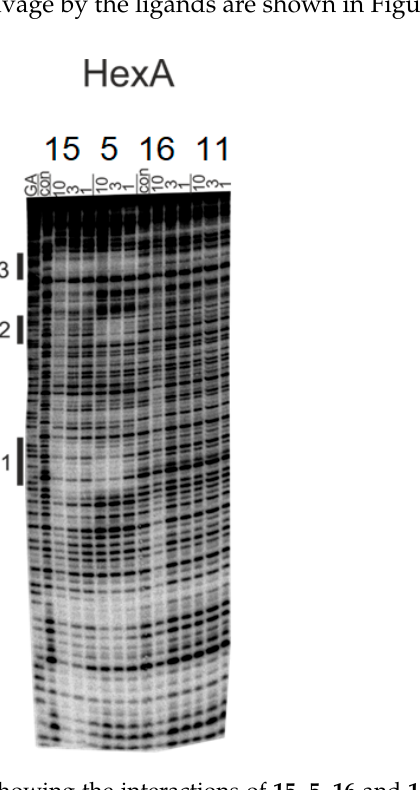
Figure 2. DNase I footprinting gels showing the interactions of 15 , 5 , 16 and 11 at 10, 3 and 1 µM concentrations with the HexA fragment. The samples were incubated with the ligand at room temperature for 24 hours before digesting with DNase I. Ligand concentrations are shown at the top of each gel lane. The tracks labelled “GA” correspond to a marker specific for purines, whereas “Con” indicates DNase I cleavage in the absence of the added ligands. Filled bars (with numbers) indicate the location of the footprints. In HexA, only PBDs 5 and 15 produced clear footprints at 5 ′ -TTAAGT/ACTAGT (site 1), 5 ′ - ACCGGT/ACCTAG (site 2) and 5 ′ -CTAGAA/TTCCGG (site 3). DC-81 ( 5 ) bound to site 1 at 3 µM and to sites 2 and 3 at the lowest concentration (1 µM), whereas benzylated PBD 15 only gave weak protection from DNase I cleavage at sites 1 and 3 at 10 and 3 µM. Examination of the footprints with the DNA fragments revealed the presence of the preferred PBD binding motif, Pu–G–Pu, for ligands 5 and 15 in site 3 of HexA (5 ′ -AGA and 5 ′ -GGA) and all sites containing 5 ′ -AG (5 ′ -CT). Notably, the novel PBD adenosine conjugate did not produce any footprints.